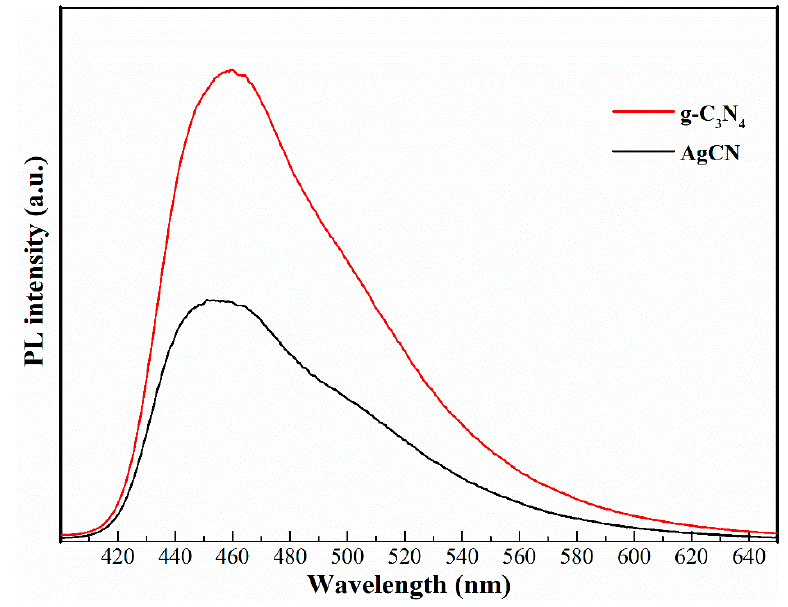
Figure 5. Photoluminescence spectrum of g-C 3 N 4 and AgCN photocatalysts.